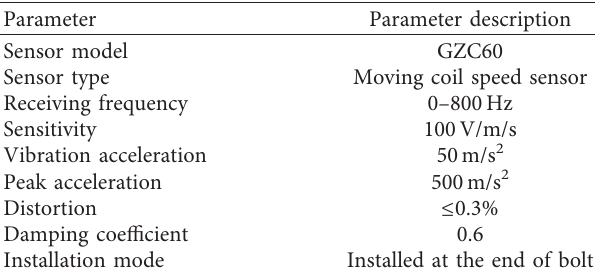
Table 2: Parameters of the sensor used in the MS system of 117 track